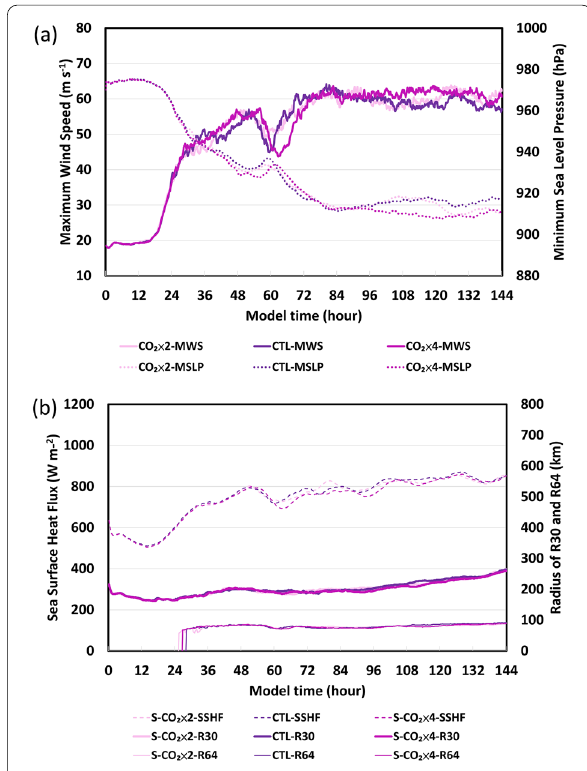
Fig. 7 Same as in Fig. 4, but is for S‑CO2